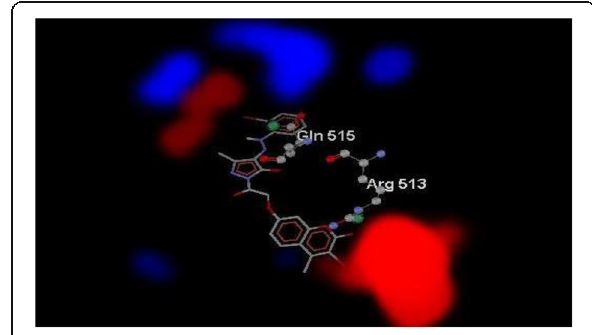
Fig. 3 Electrostatic force of attraction between compound D1